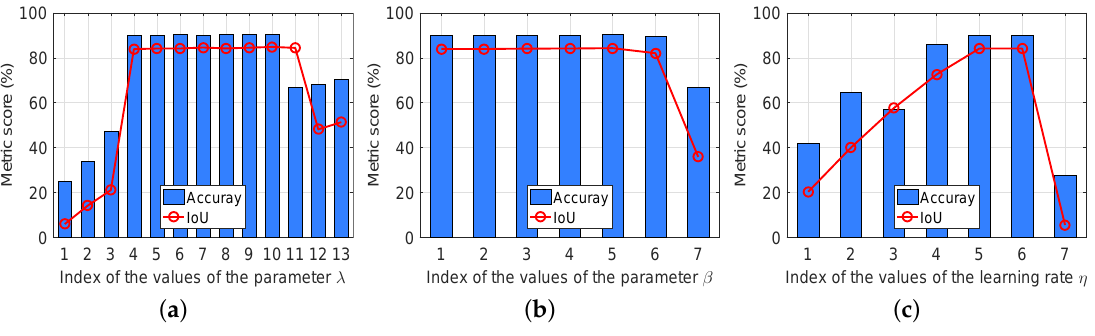
Figure 6. Effects of regularization parameters λ and β in the objective function in Equation (8) and learning rate η when employing GSD strategy to train the model. Scores were obtained on the Potsdam dataset. Metric scores of ( a ): parameter λ ; ( b ) parameter β ; and ( c ): parameter η